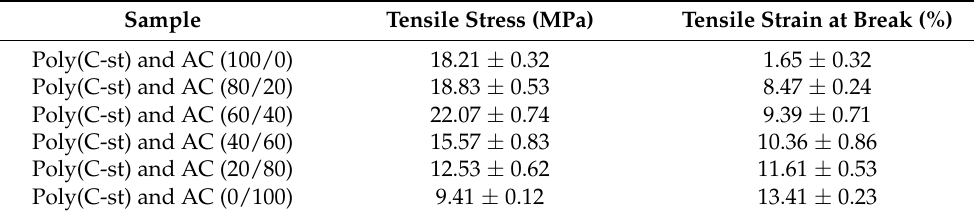
Table 3. Data obtained from stress–strain